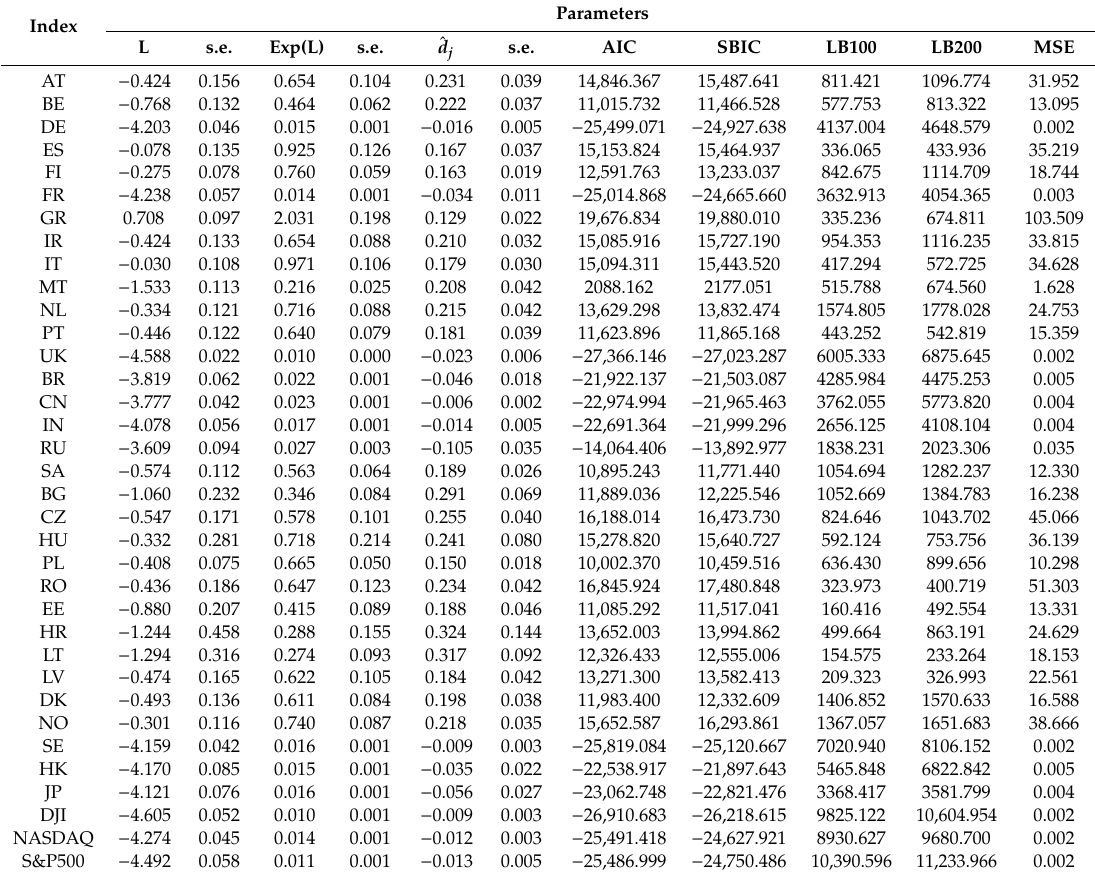
Table 3. Estimates of conditional heteroskedasticity long memory